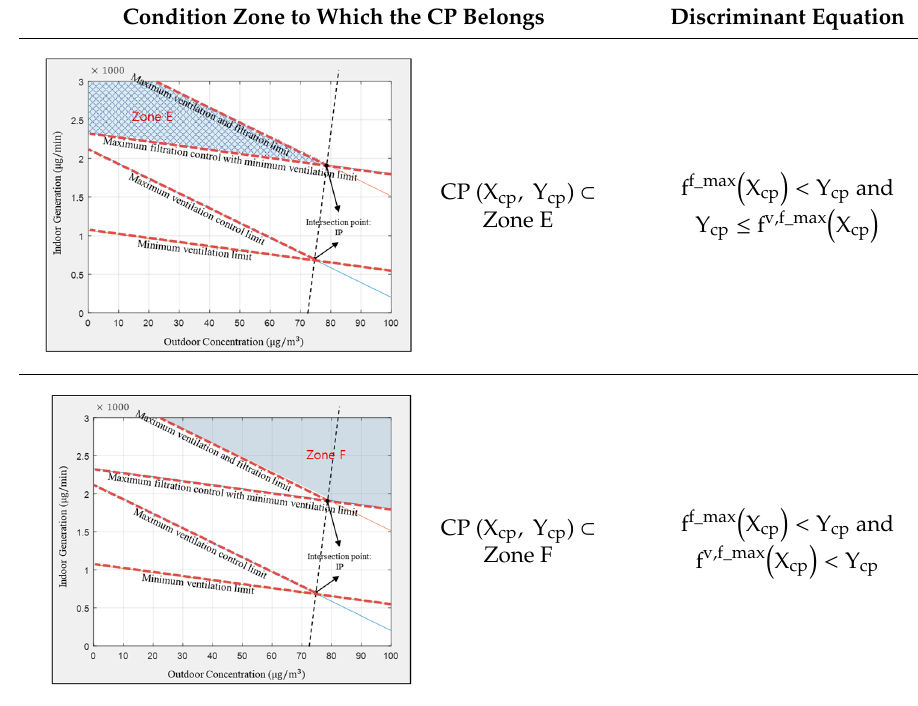
Table 4. Cont. Condition Zone to Which the CP Belongs Discriminant